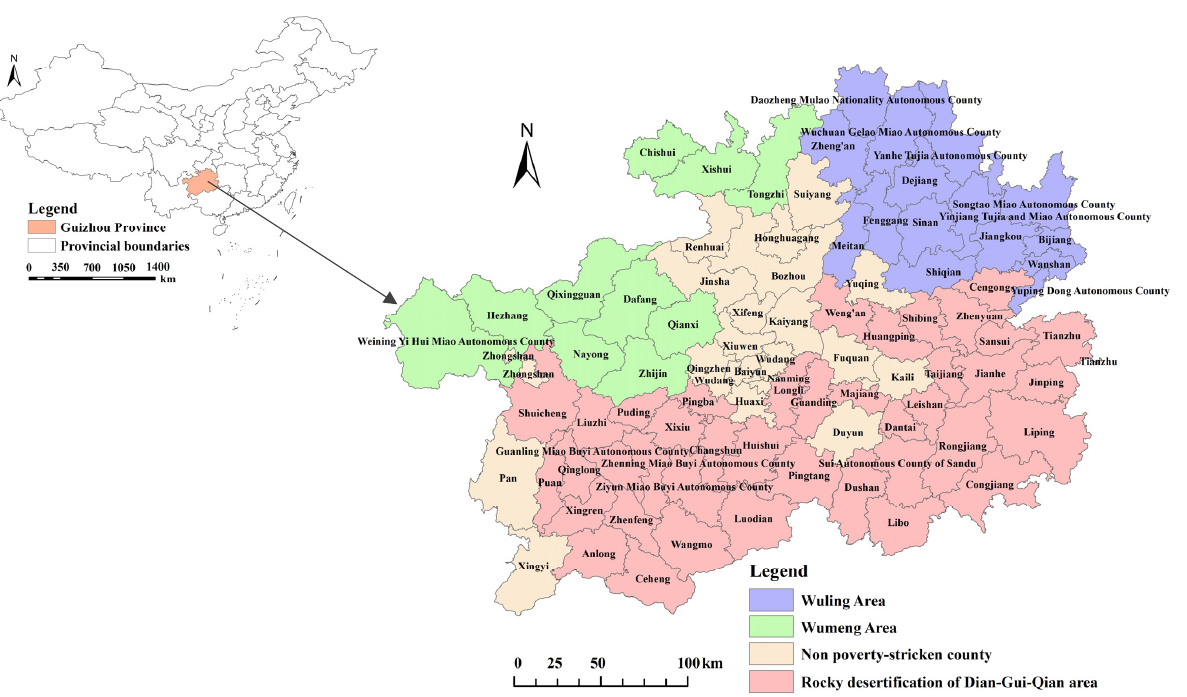
Figure 1. Map of the study area of the 3 continuously poverty-stricken areas in Guizhou Province,